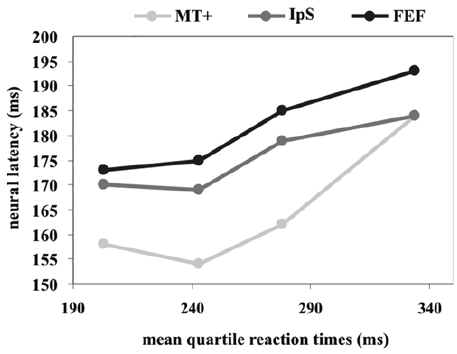
Figure 4. Mean neural latency and SRT quartiles. The x axis represents the mean quartile SRT. The y axis represents the peaks of visual response for MT + (light grey), IPS (dark grey) and FEF (black) regions,